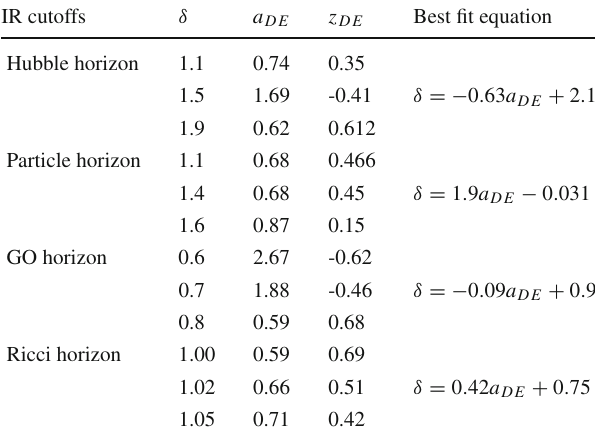
Table 1 The table shows the scale factor for minimum a DE , redshift of transition z DE for different choices of the non-additivity parameter δ and the best fit equation for δ as a function of a DE for the THDE model with different IR cutoff